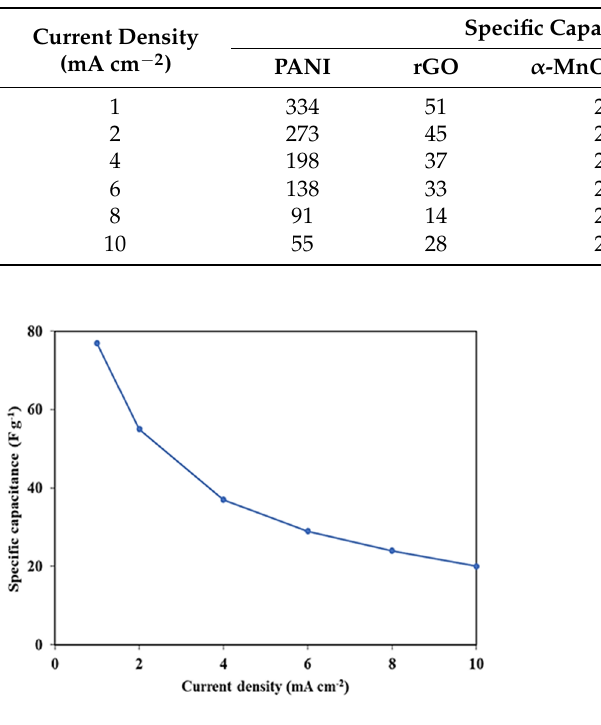
Figure 7. Plot of speci fi c capacitance vs. current density of α -MnO 2 /PANI/rGO. Table 2. Speci fi c capacitance values calculated from